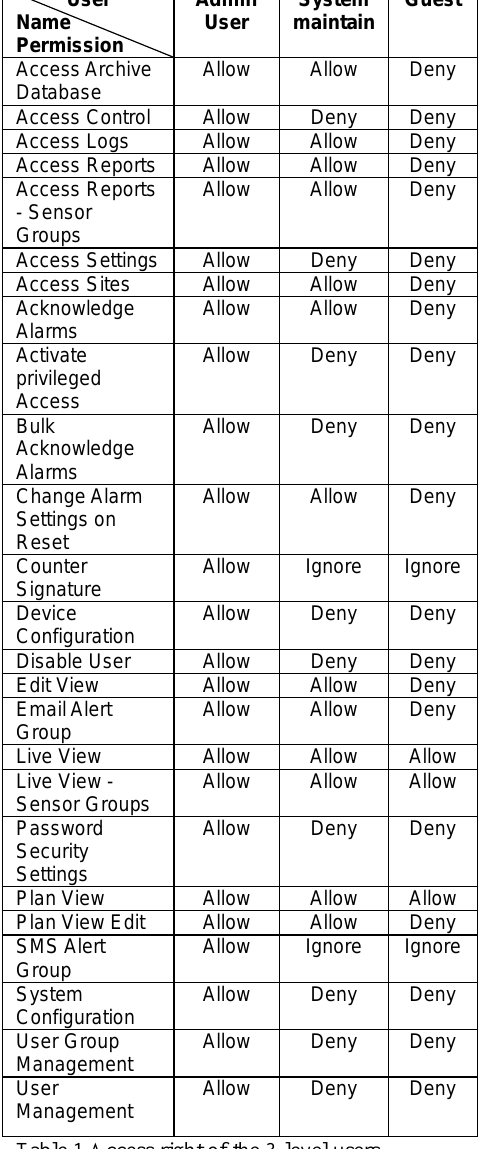
Table 1 Access right of the 3-level users Synchronizing and configuring the